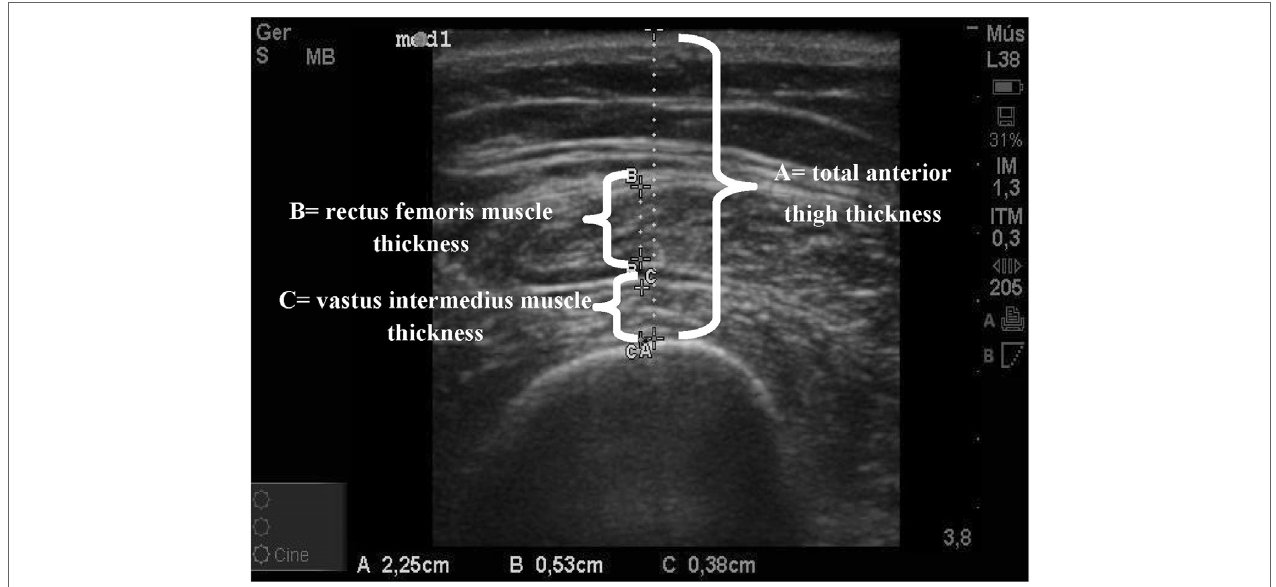
FigUre 1 | Ultrasound scan with measurements of the dominant thigh. A = total anterior thigh thickness in centimeters; B = rectus femoris muscle thickness in centimeters; C = vastus intermedius muscle thickness in centimeters; B + C = quadriceps muscle thickness in centimeters